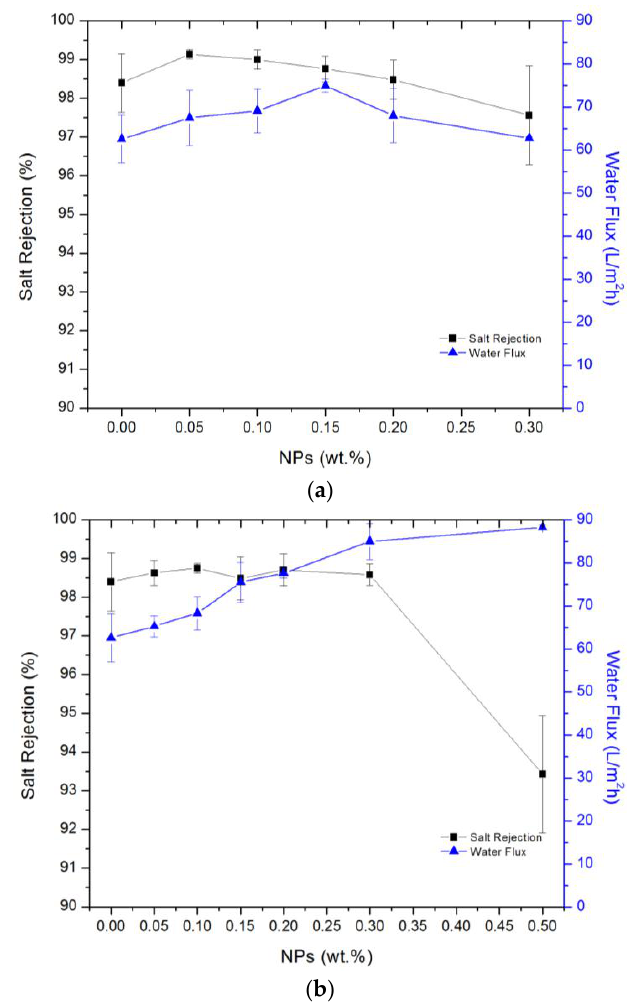
Figure 8. TFN membranes performance with injected ( a ) UiO-66 and ( b ) MIL-125 NPs.